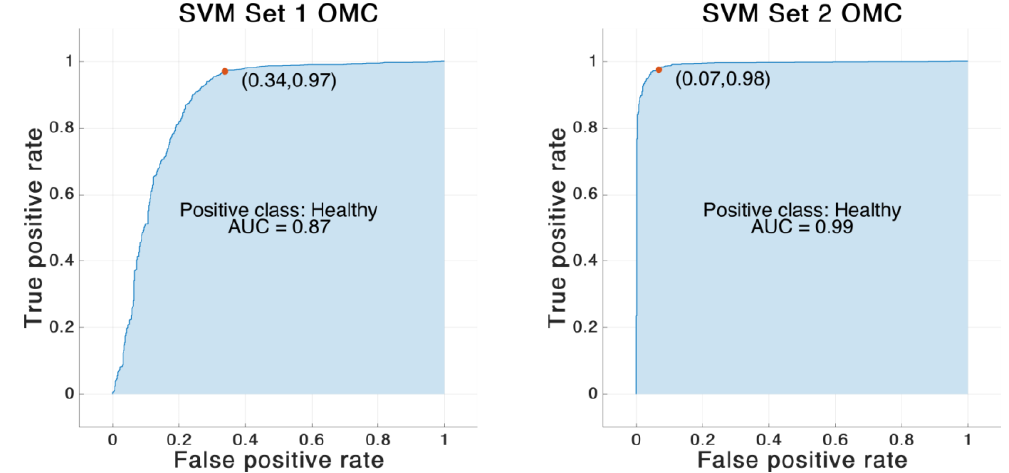
Figure 6. Receiving operating characteristic (ROC) curve for the SVM model trained on IMU-based feature Set 1 and 2. The red dot marks the performance of the corresponding model. The blue area indicates the area under the curve (AUC).